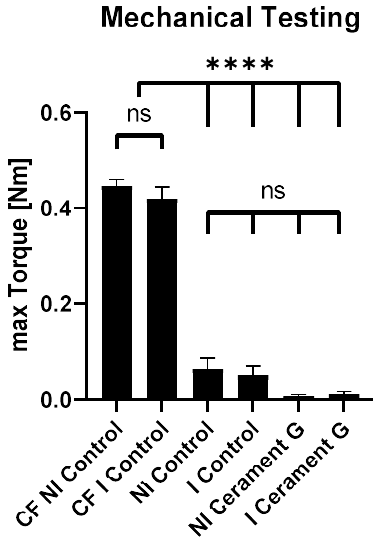
Figure 1. Microbiologic results of all animals after second surgery and euthanasia. Rats with secondary infection and colonization are both displayed as part of the S. aureus group.